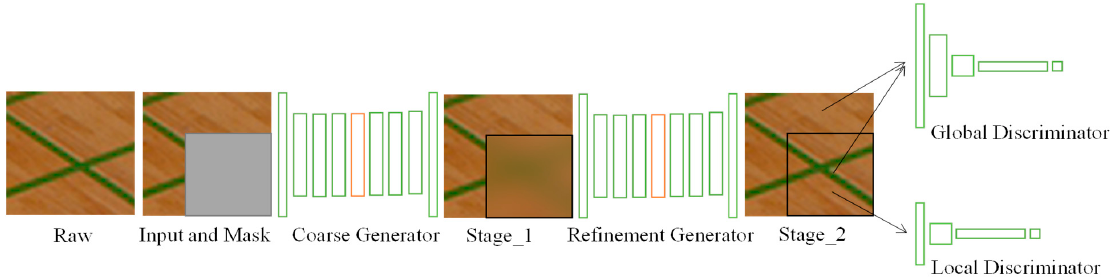
Figure 4. Illustration of the proposed generative adversarial network framework.